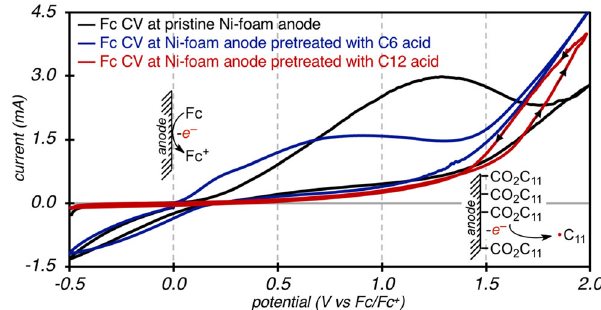
Fig. 4 CV Studies of SAMs. CV of ferrocene (10 mM) with pristine Ni-foam (black), C6 pretreated Ni-foam (blue), and C12 pretreated Ni-foam (red). CV conditions: 0.1 M KPF 6 in MeCN, 100 mV/s scan rate, room temperature, Ni-foam working electrode (WE), and RVC counter electrode (CE).